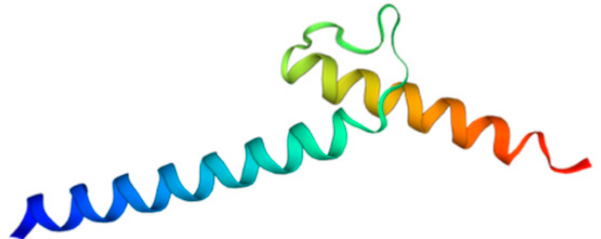
Figure 1. Structure of bHLH domain of Atoh8 predicted by Swiss-Model [14].